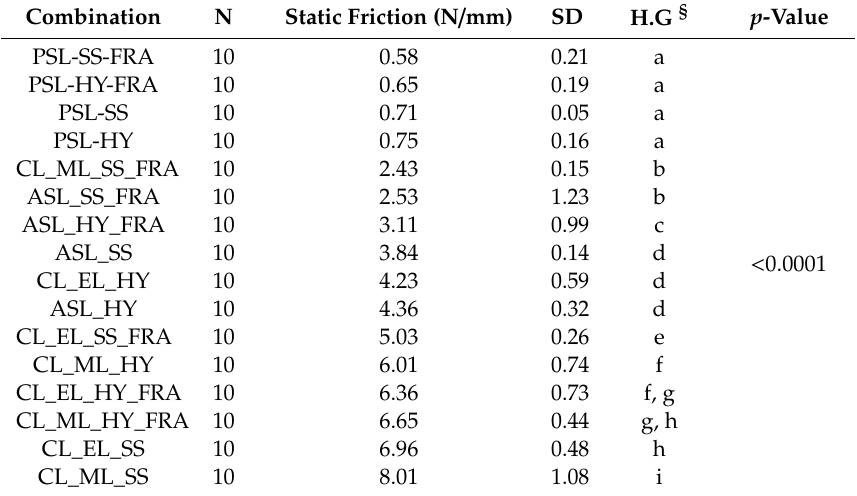
Table 1. Static friction values in all possible combinations of brackets: active self-ligating(ASL), passive self-ligating (PSL) and metallic conventional ligating (CL). The letters show significance statistical di ff erences.